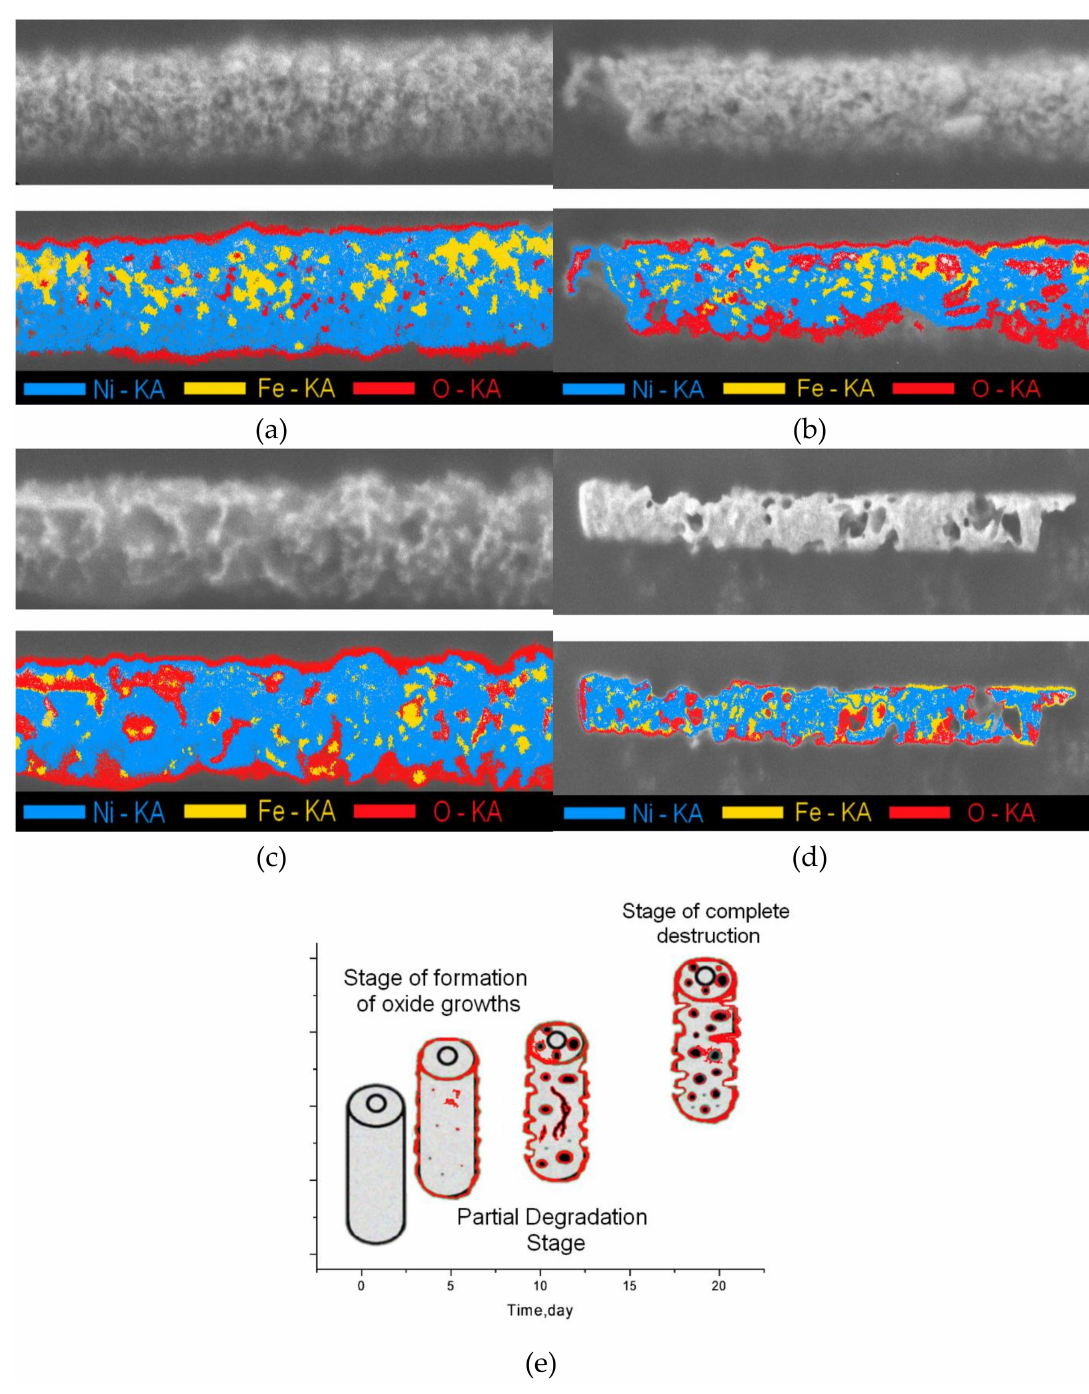
Figure 5. SEM images of the stages of degradation of the initial nanostructures: ( a ) 3 days of testing; ( b ) 5 days of testing; ( c ) 10 days of testing; ( d ) 20 days of testing. ( e ) Diagram of degradation of